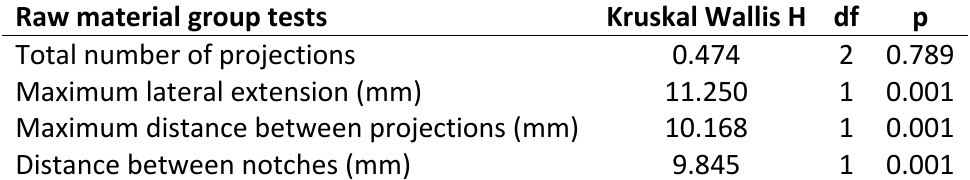
Table 10. Kruskal Wallis tests for raw material groups and projection metrics.